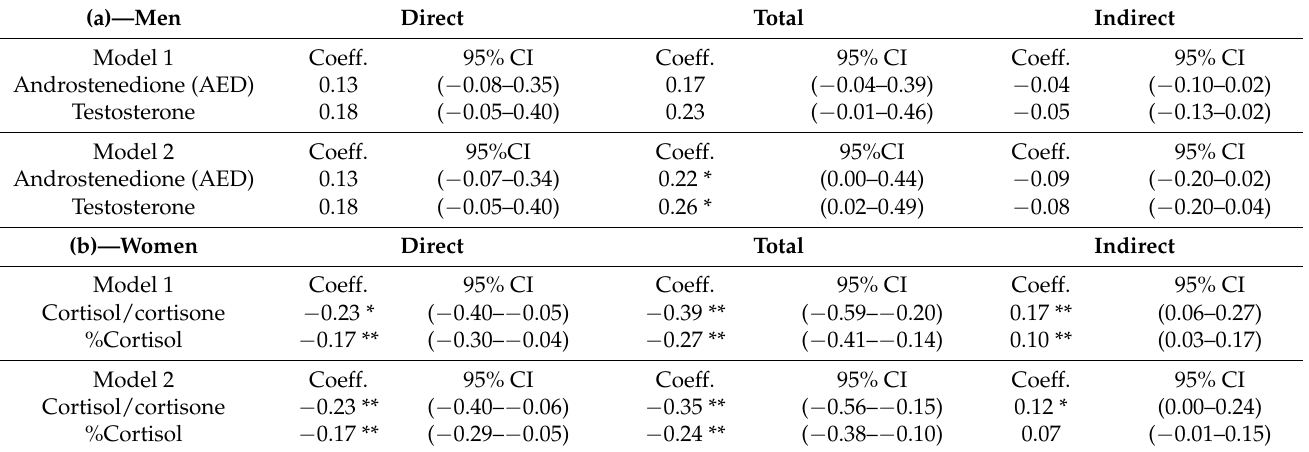
Table 3. Linear regression coefficients and 95% confidence intervals (CIs) for the production of adrenal and gonadal steroids and PE and PRFs, adjusted for control variables and stratified by sex, using the KHB method. Robust standard errors. Precarious Employment and Stress Study sample,